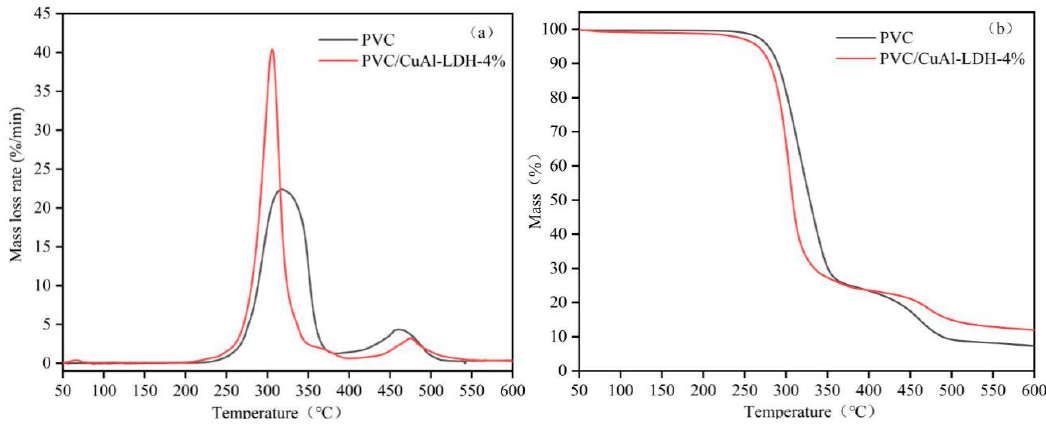
Figure 2. DTG and TG curves for the degradation of PVC and its composite: ( a ) the curve of DerivativeThermogravimetry; ( b ) the curve of Thermogravimetry.